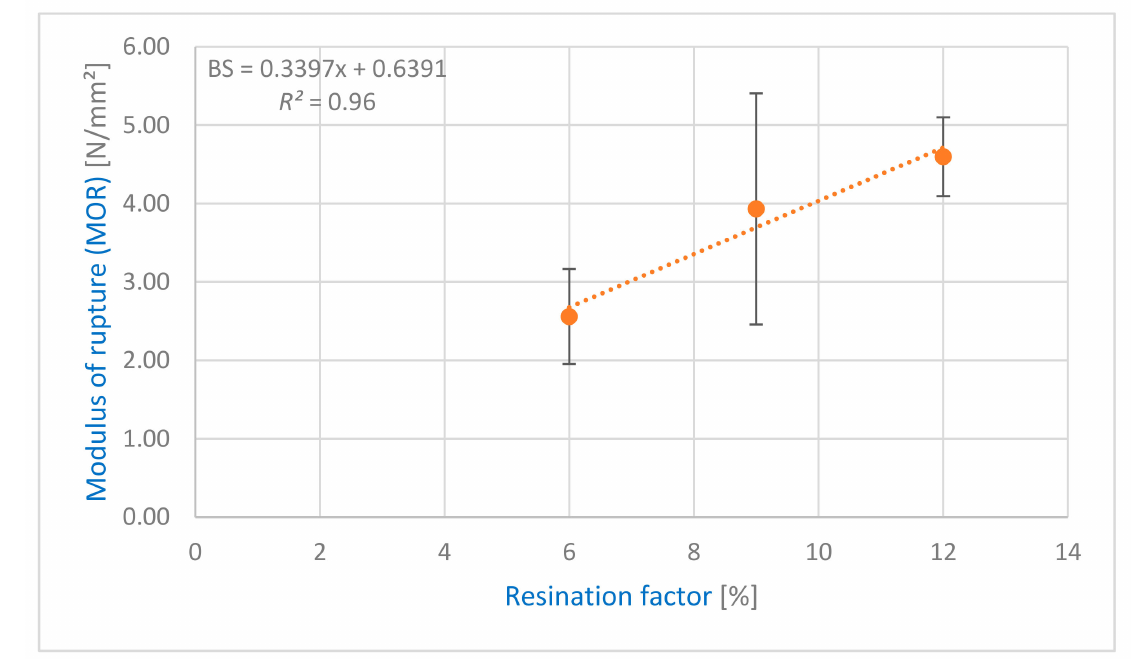
Figure 4. Regression model of resination factor (6%, 9%, and 12% UF), and modulus of rupture (MOR) of the light particleboard with PS.